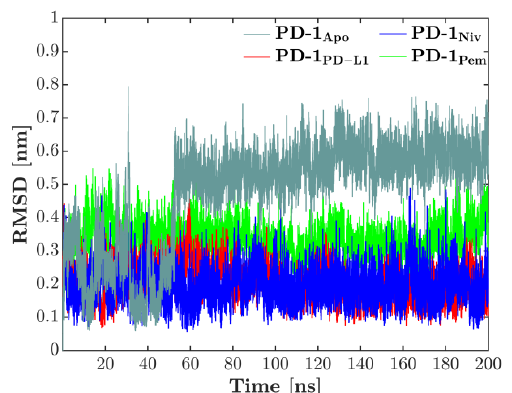
Figure 2. RMSD of CC‘-loop in all 4 systems, computed versus the first configuration of each simulation. While all bound states show regular fluctuations, the unbound system (PD-1 Apo ) exhibits a fluctuating behavior, starting at a lower level around 0.3 nm. Around 50 ns the CC’-loop deforms and accordingly the RMSD increases to 0.6 nm. Note that also around 30 ns, a very short, reversible jump is visible.